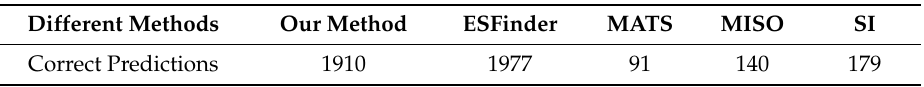
Table 5. The predictions of RotaF-RSES, ESFinder, MATS, MISO, and SI for independent test data. Different Methods